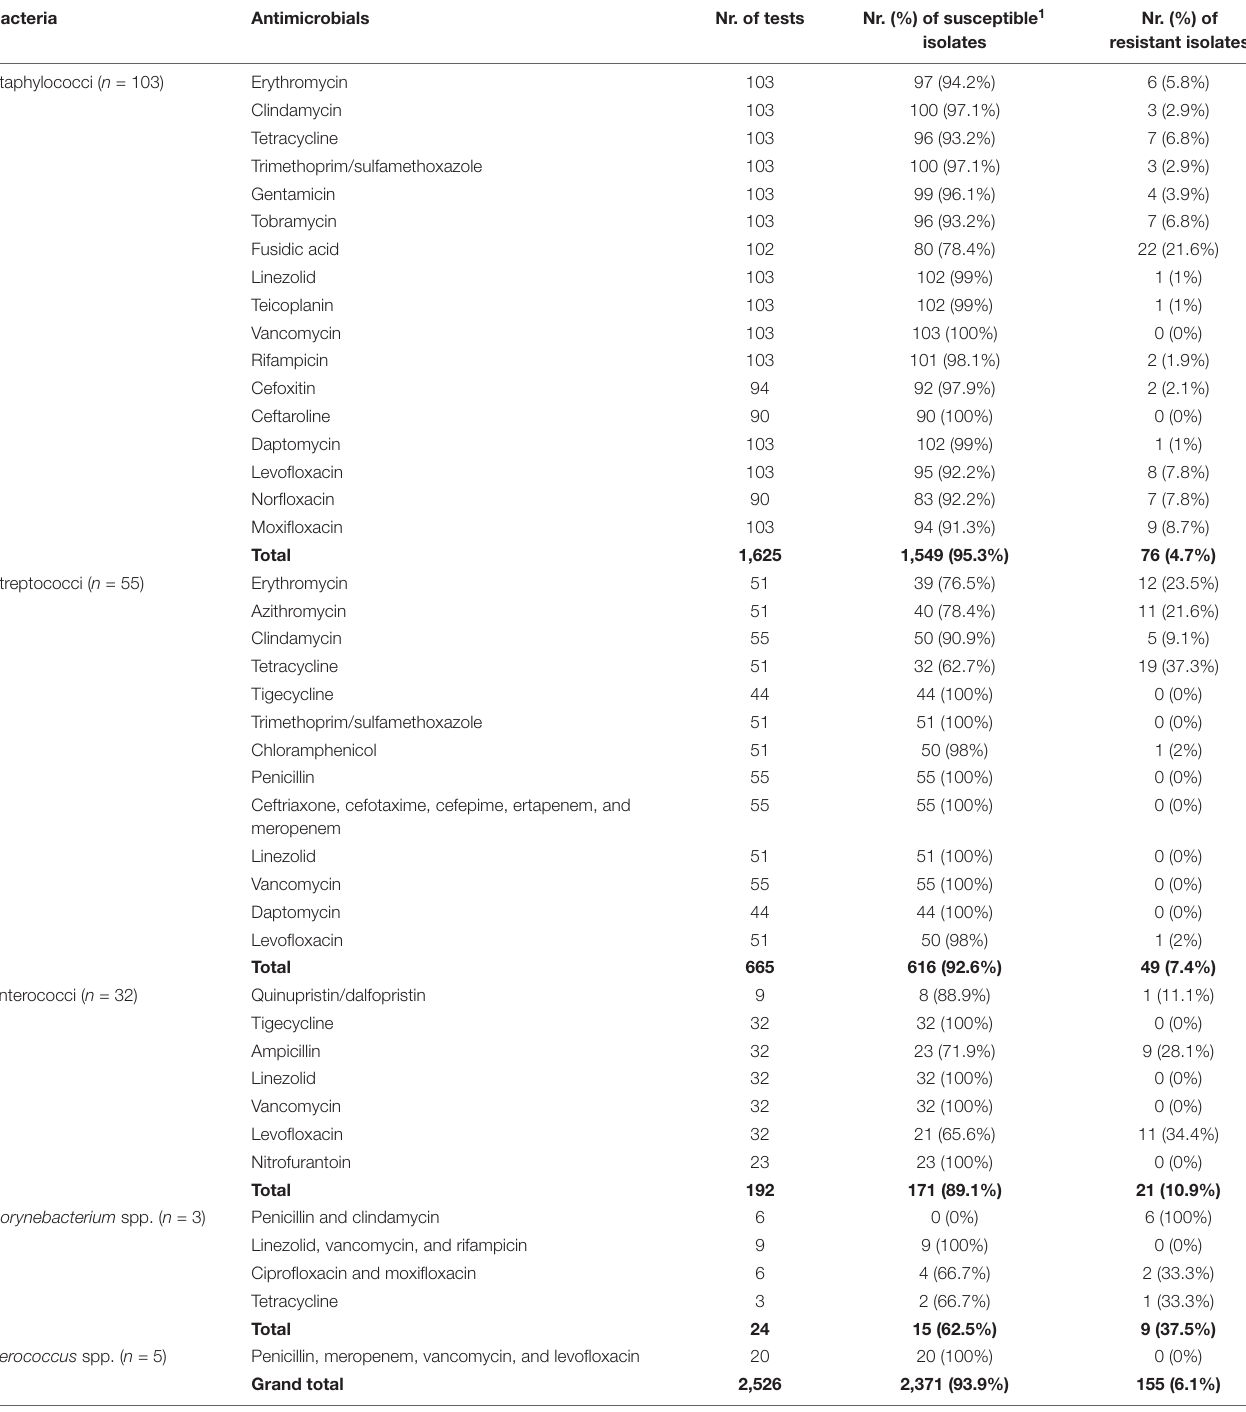
TABLE 2 | Phenotypic antimicrobial susceptibility testing (AST) results obtained through broth microdilution (BMD) for the main Gram-positive bacterial taxa in this study. Bacteria